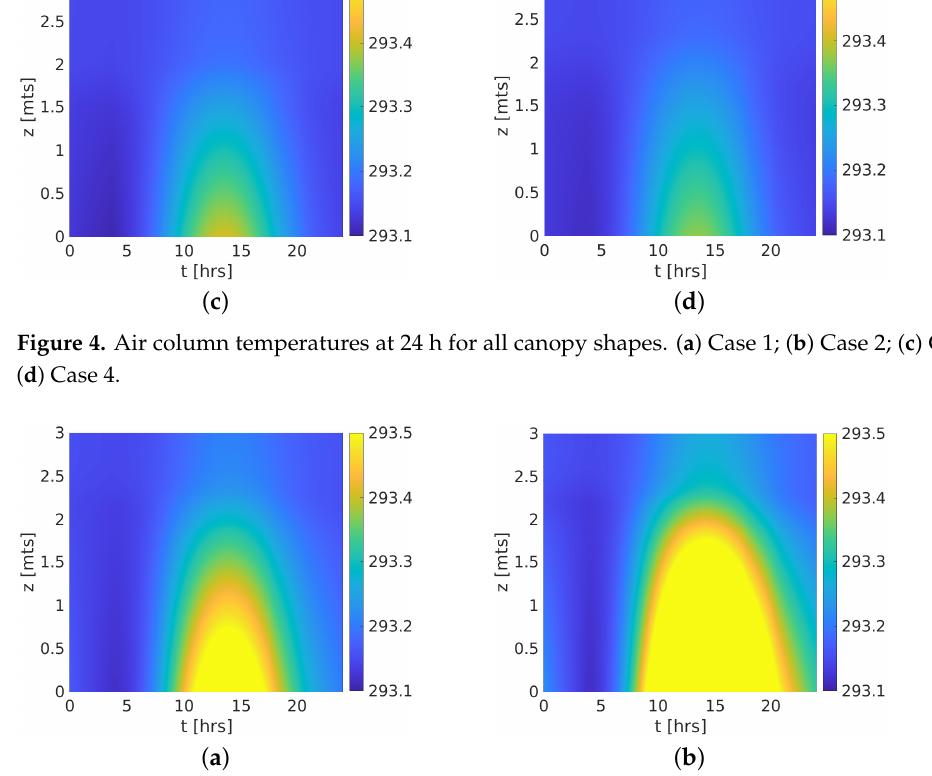
Figure 5. Wind velocity partly explains the scant variability of the temperature in the air column. Temperatures at 24 h for the canopy shape 2 subjected to different wind velocities. ( a ) Case 2 u ref = 5 m/s; ( b ) Case 2 u ref = 2.5